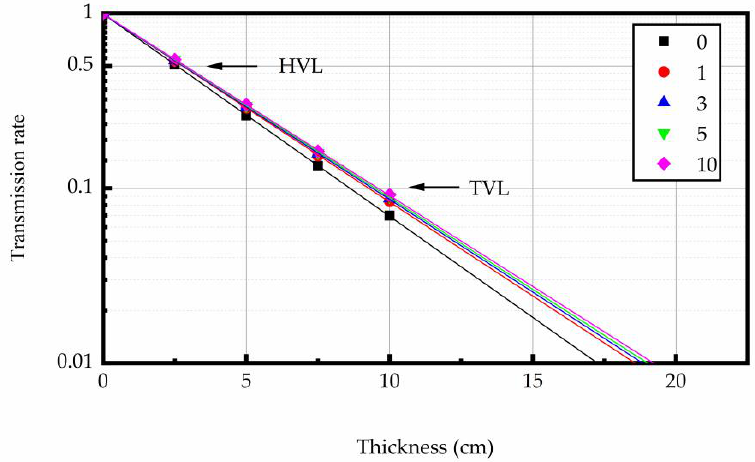
Figure 16. The relation between gamma-ray transmission rate and the concrete thickness at 300 °C.